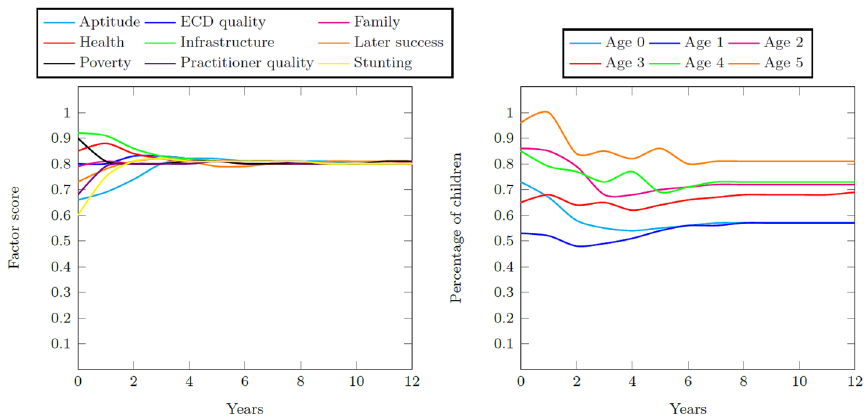
Fig. 12 Factor scores during the 12-year simulation period for the Quintile 4 and 5 base case and the percentage of children with adequate development for their age for the Quintile 4 and 5 base